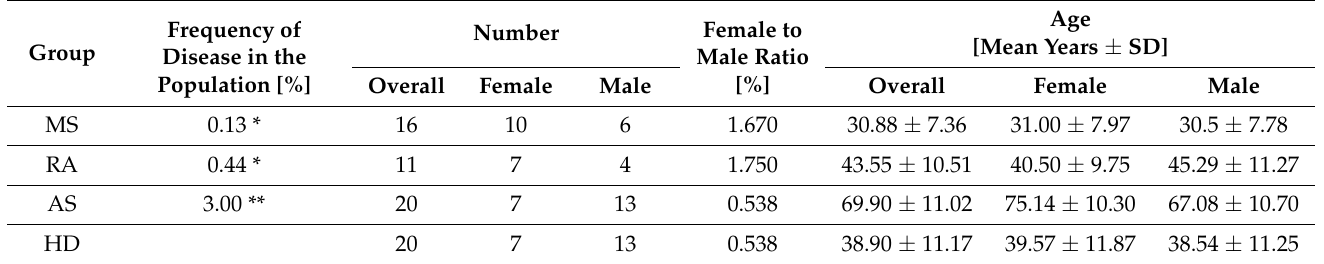
Table 1. Basic clinical characteristics of the groups of patients and healthy donors participated in the